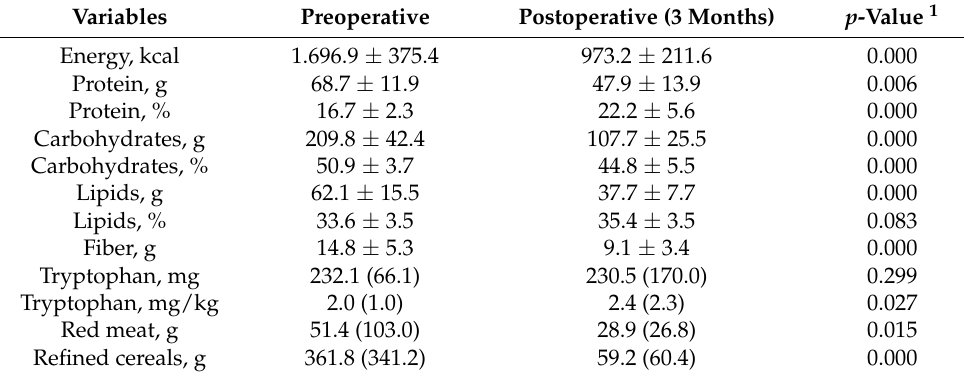
Table 2. Food intake variables before and three months after RYGB.